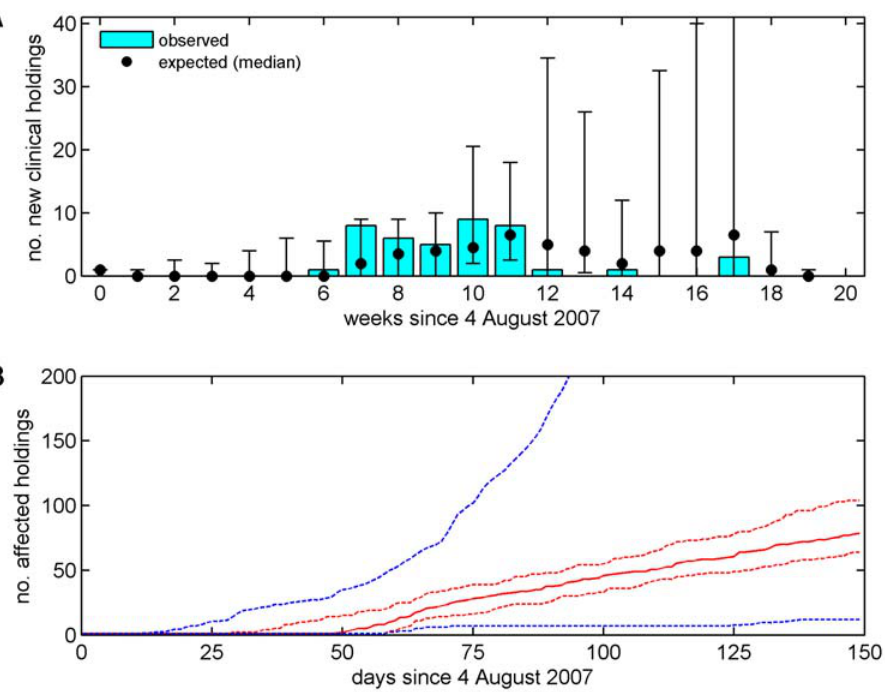
Figure 3. Temporal dynamics of BTV-8 in GB during 2007. (A) Observed and expected number of farms reporting clinical disease each week. The figure shows the observed number of newly-identified holdings with confirmed clinical cases (bars) and the median (symbols) and 10th and 90th percentiles (error bars) for the simulated outbreaks. (B) Expected cumulative number of affected holdings over time. The figure shows the median (solid red line), 25th and 75th percentiles (red dashed lines), and 10th and 90th percentiles (dashed blue lines). Each figure shows the results for the simulated epidemics assuming a Gaussian transmission kernel and demographic model presented in Table 4 (i.e. the best-fit model to the northern European data), based on the results of 50 simulated outbreaks which took off (see Methods).